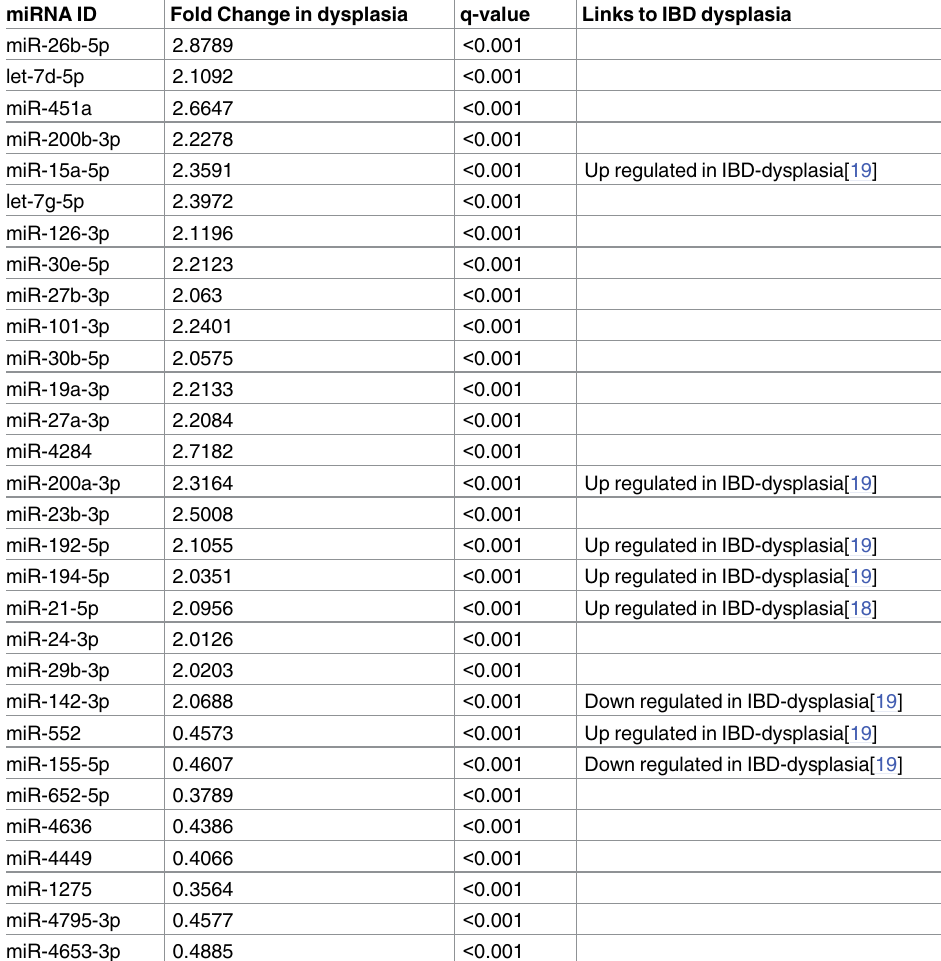
Table 2. miRNAs associated with ulcerative